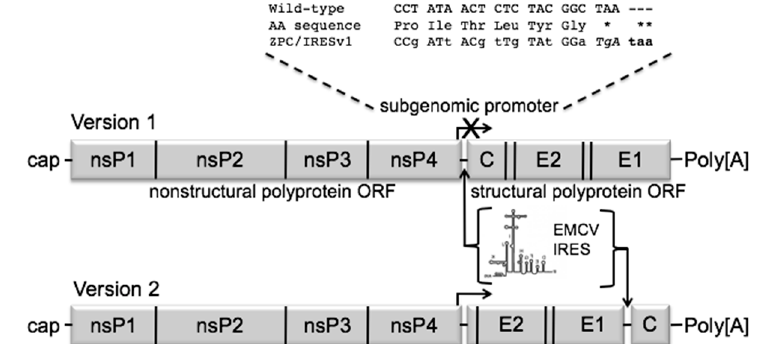
Figure 1. Schematic diagram of the ZPC / IRES vaccine constructs. The subgenomic promoter ablation mutations are shown as lower-case letters. The corresponding amino acid sequence confirming noncoding mutations is shown between the wild type and mutant sequences. The inserted stop codon is shown in bold. * indicates stop codon mutated from ochre to opal. ** indicates an inserted ochre stop codon. Genomic schematics of versions 1 and 2 show the locations of the IRES insertion in lieu of the subgenomic promoter or just upstream of the capsid gene,